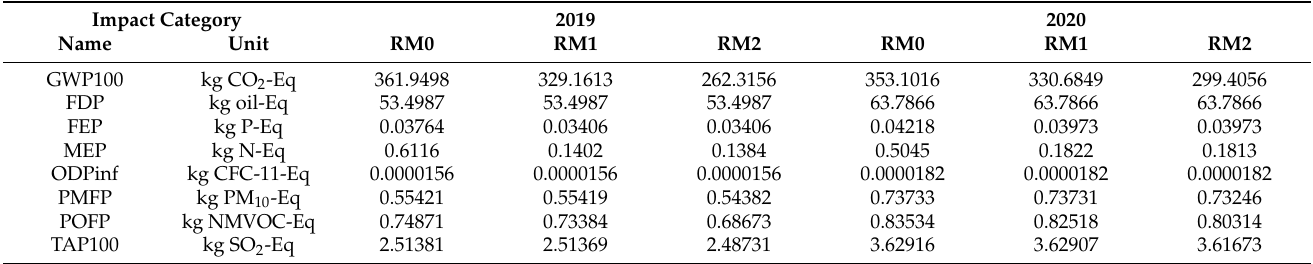
Table 5. Impact category indicator results for 1 ton “Banana at-the-packaging-stage-gate” for the three rachis management scenarios.